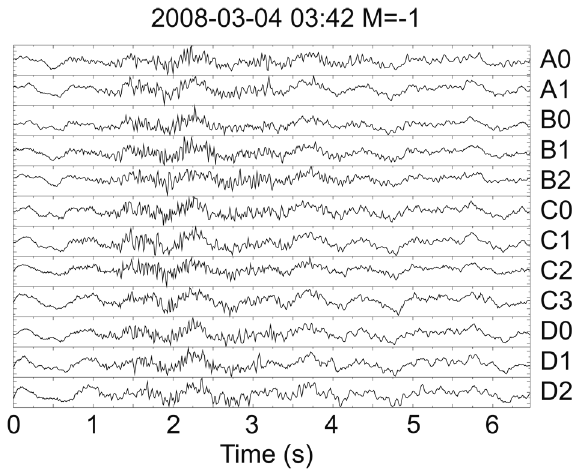
Figure 6 (above). Traces of a M = −1 earthquakes recorded by the seismic array on March 4, 2008, at 03:42 UTC. Amplitudes are nor- malized. Label on the right indicate the array elements (see Figure 5). Figure 7 (right). Backazimuth and apparent velocity analysis of an M = 1 earthquake recorded by the seismic array on September 11, 2009, at 21:06 UTC. The size of circles in the two lower panels is proportional to the beam energy.